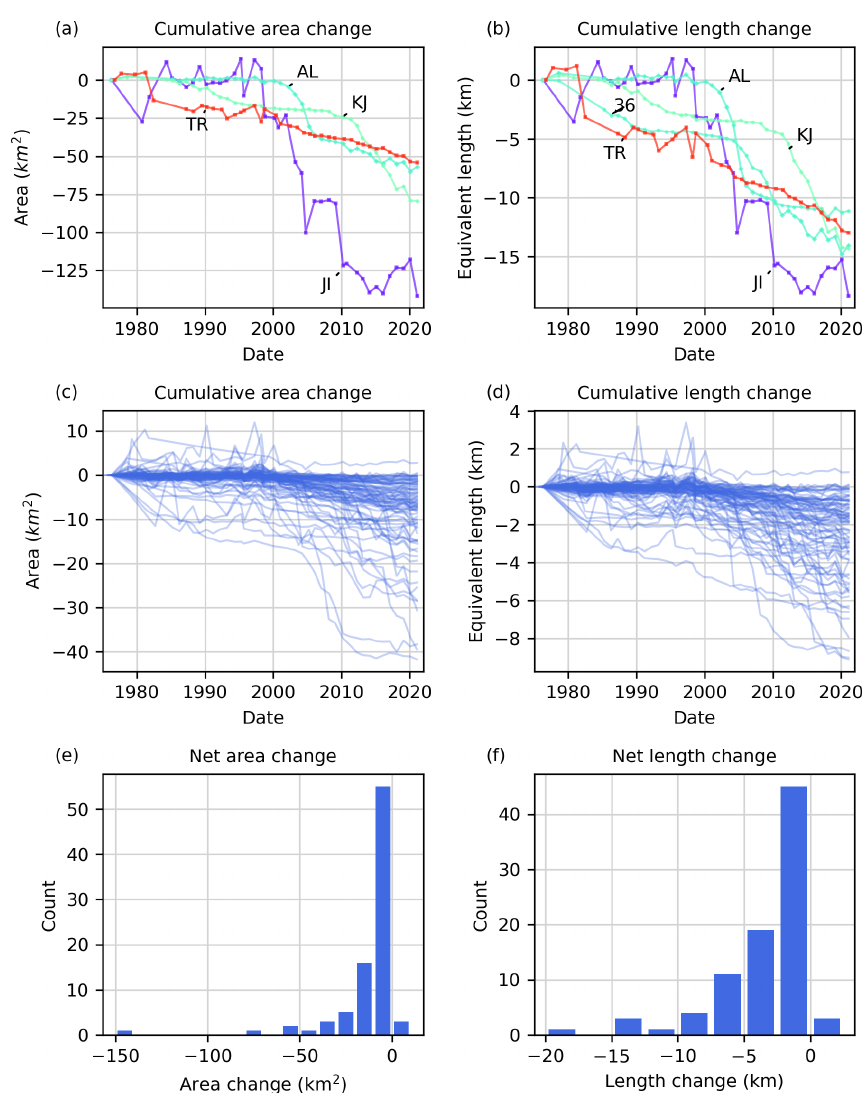
Figure 4. Cumulative (a) area change and (b) length change for large glaciers that dominate the total observed change. Glacier changes in each plot are labeled using the abbreviation scheme in Fig. 1. The color map follows the order of the glaciers (from south to north), so glaciers with similar colors are spatially closer together. For all other glaciers, cumulative (c) area change and (d) length change are provided but not distinguished by glacier. The final net (e) area change and (f) length change are reported as